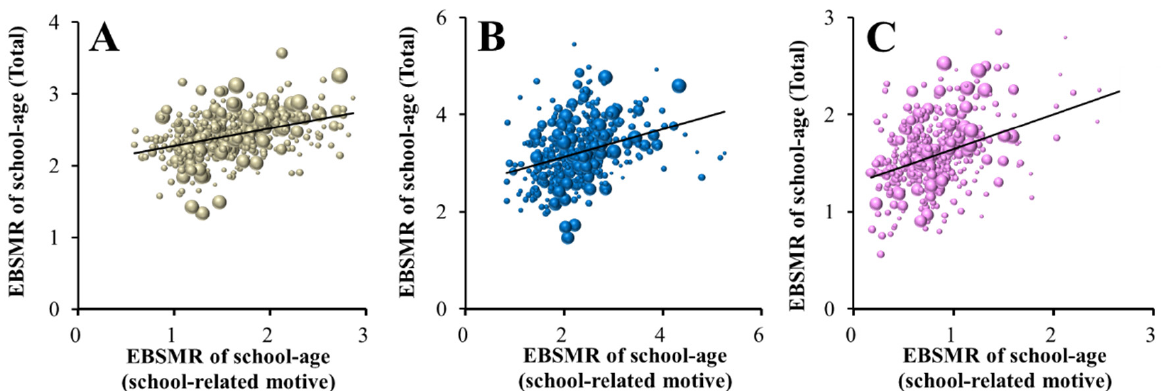
Figure 5. Relationships between EBSMRs of suicide mortalities of school-aged population (total) (younger than 20 years old) and suicide mortalities caused by school-related motives of school-aged populations in Male+Female ( A ), males ( B ) and females ( C ) were analysed by linear regression analysis. Abscissas indicate the EBSMRs of school-related motives among those over 10 years old, and ordinates indicate the EBSMRs of the suicide numbers of those over 10 years old between 2009 and 2018. Grey, blue and red spheres indicate Male+Female, male and female EBSMRs of all prefectures from 2009 to 2018. Black lines indicate the regression lines of significantly positive factors.